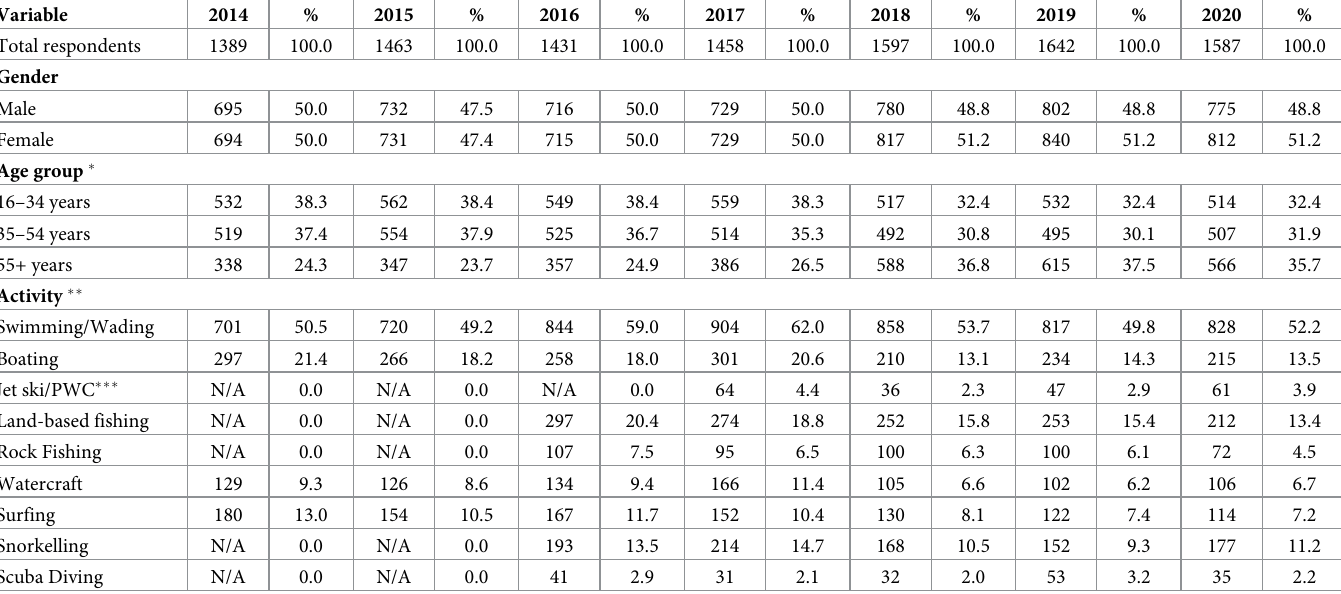
Table 3. Number and proportion of survey respondents each year by key demographics and